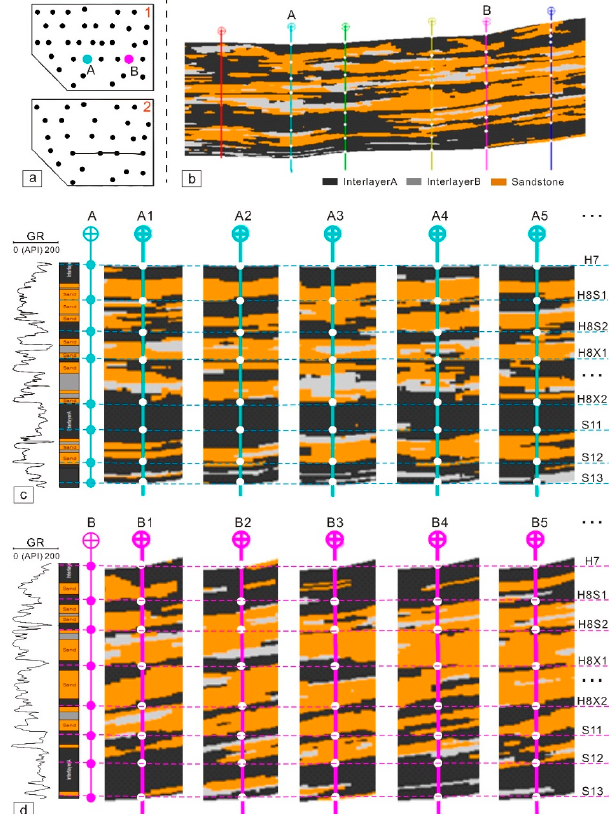
Figure 8. ( a ) The original (the upper one) and the vacuated well pattern (the lower one), showing the locations of eight removed wells; ( b ) Cross-section of sandstone and mudstone model, within which well A and well B did not participate in the modeling process; section location is drawn in Figure 8(a2); ( c , d ) Comparison between five stochastic realizations or prediction models ( A1 , A2 , …, A5 and B1 , B2 , …, B5 ) and 1-D interpreted sandstone and mudstone model of well A and well B, respectively.